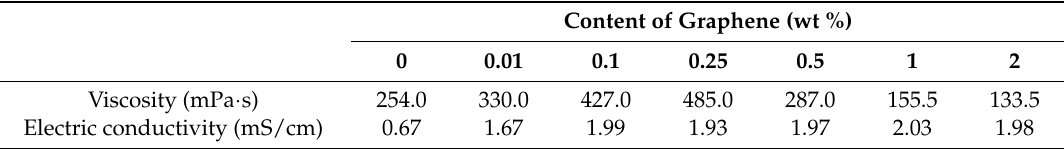
Table 1. Viscosity and conductivity of the polyvinyl alcohol (PVA) solution. Content of Graphene (wt %)